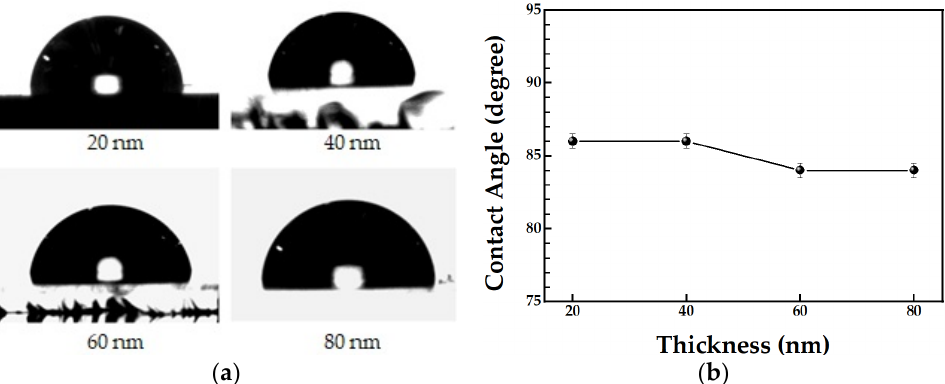
Figure 3. Contact angle ( a ) images and ( b ) values of the RF-PECVD DLC thin films with various film thicknesses: 20, 40, 60, and 80 nm.